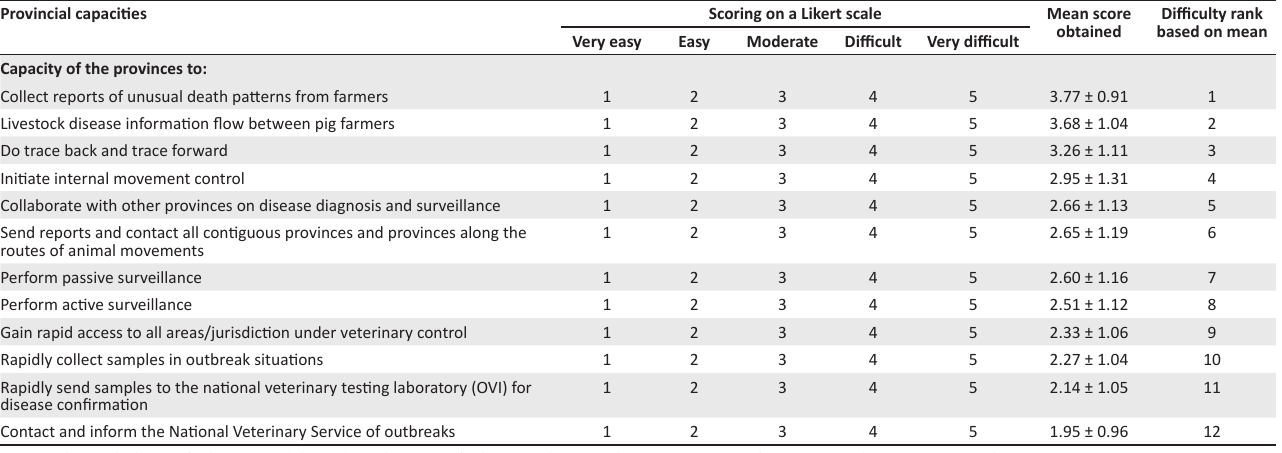
TABLE 1a: Self-rated questionnaire on the ease of providing pig-related veterinary services in South African provinces. Provincial capacities